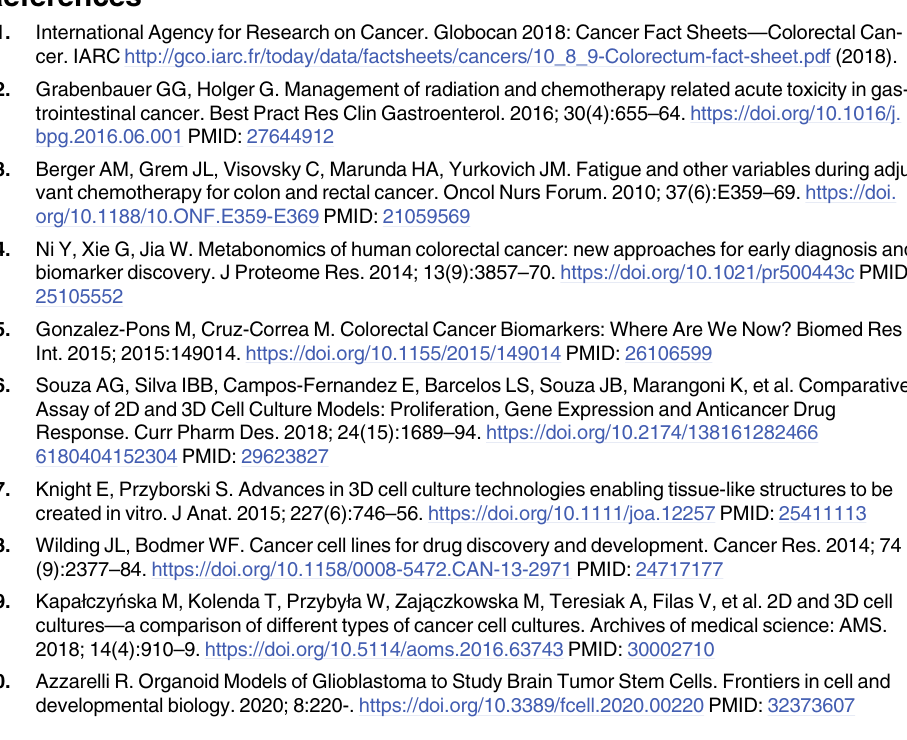
10. Azzarelli R. OrganoidModels of Glioblastoma to Study Brain Tumor Stem Cells. Frontiers in cell and developmental biology.2020; 8:220-. https://doi.org/10.3389/fcell.2020.00220 PMID: